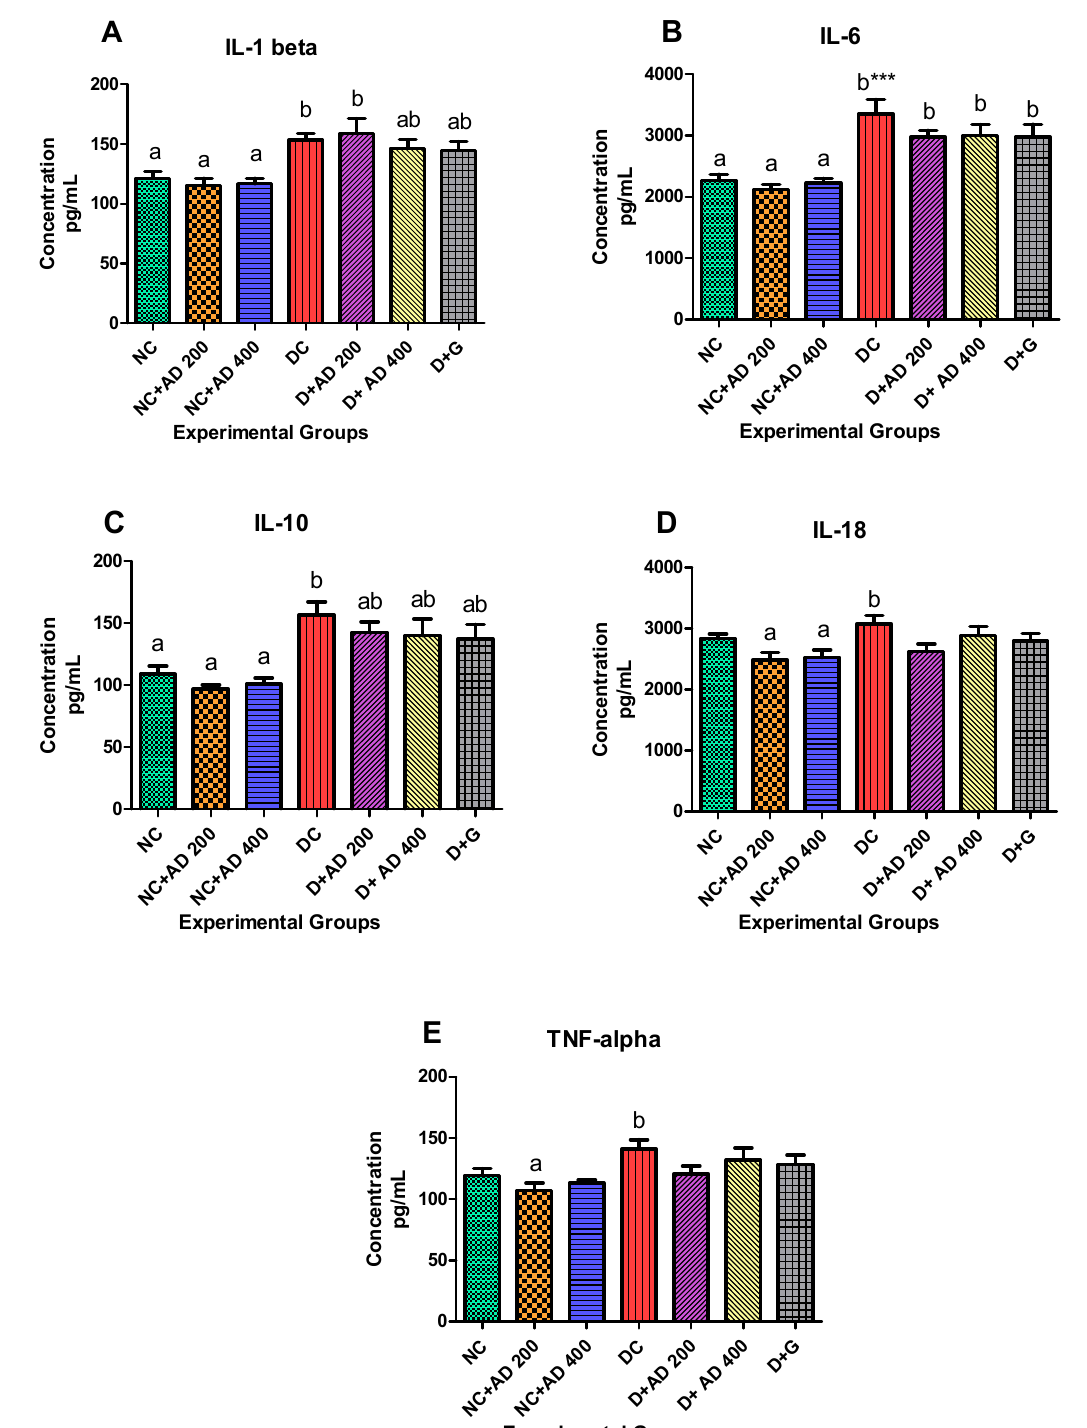
Figure 5. Effect of AD administration on interleukins (IL) ( A ) IL-1 β , ( B ) IL-6, ( C ) IL-10 ( D ) IL-18 and ( E ) TNF-alpha in the kidney of normal and diabetic rats. Bars are indicative of mean values ± SEM of group values. Bars with different letters are significantly ( p < 0.05) different from each other, while bars with *** is significantly different at p <